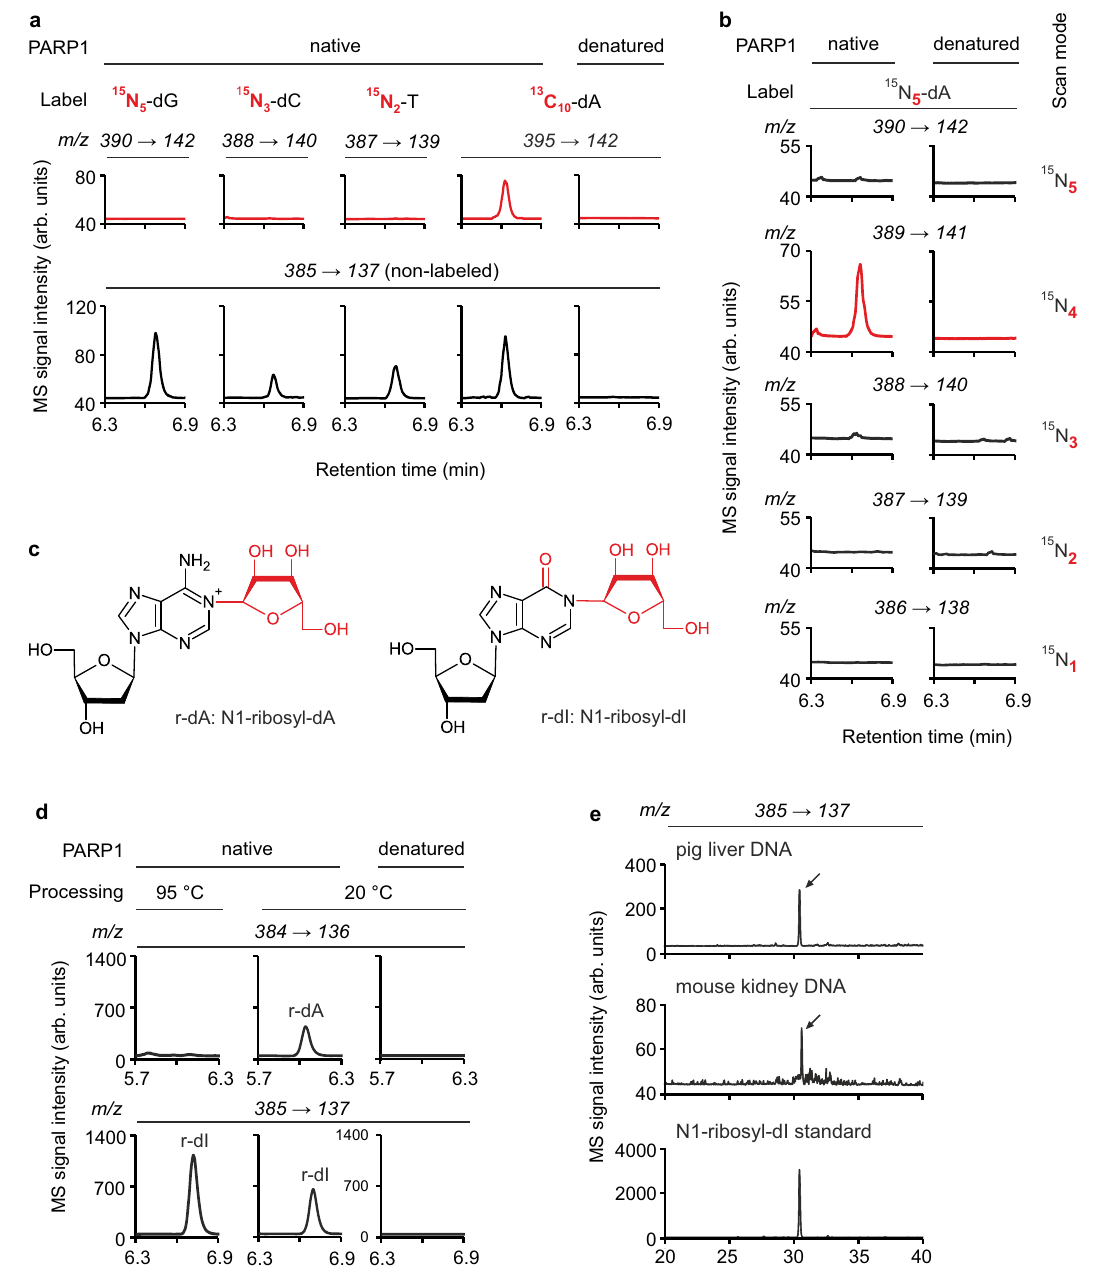
Fig.4|DNAPARylationoccursattheN1-positionofadenosineresiduesinvitro and in vivo. a LC-MS/MS chromatograms of reaction products from in vitro PAR- ylation assays in presence of native or heat-denatured PARP1 with four 83mer ssDNA substrates each bearing one type of heavy isotope-labeled nucleoside as indicated. Top, scan for signals with m/z transitions expected for a mass shift of ‘ nucleoside 385 ’ from each label. Bottom, detection of signals that correspond to non-labeled ‘ nucleoside 385 ’ . Note, all four substrates contain a mixture of the respective labeled and unlabeled nucleoside. b LC-MS/MS chromatograms of reaction products from invitroPARylation assays asin a but with a 15 N 5 -dA-labeled 83mer ssDNA substrate. Reaction products were scanned for signals with m/z transitions that correspond to mass shifts of +5 to +1 of ‘ nucleoside 385 ’ (from top